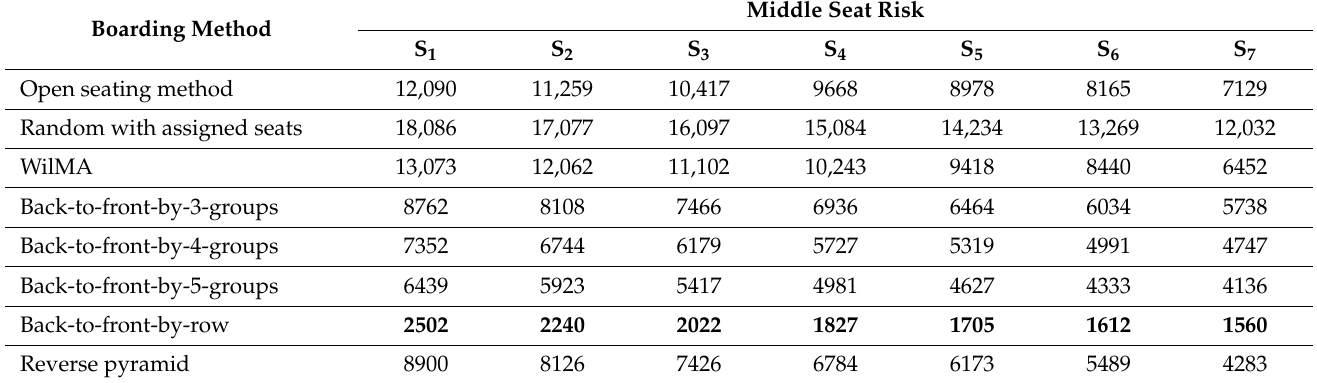
Table 4. Middle seat